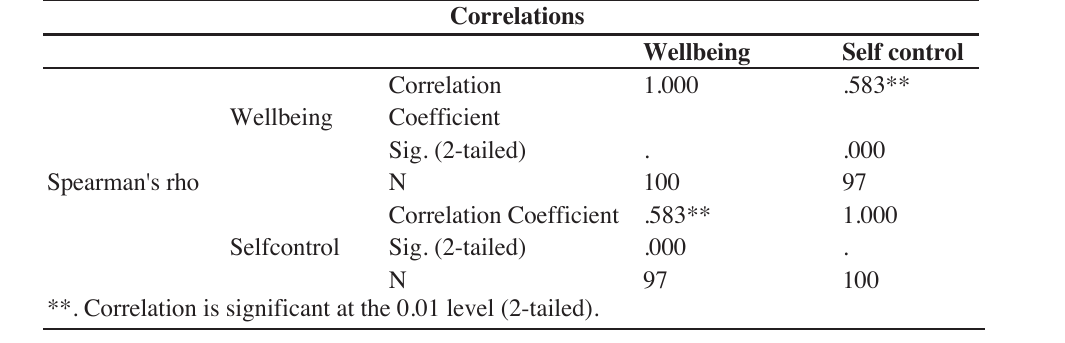
Table 1: Correlation between wellbeing and self control